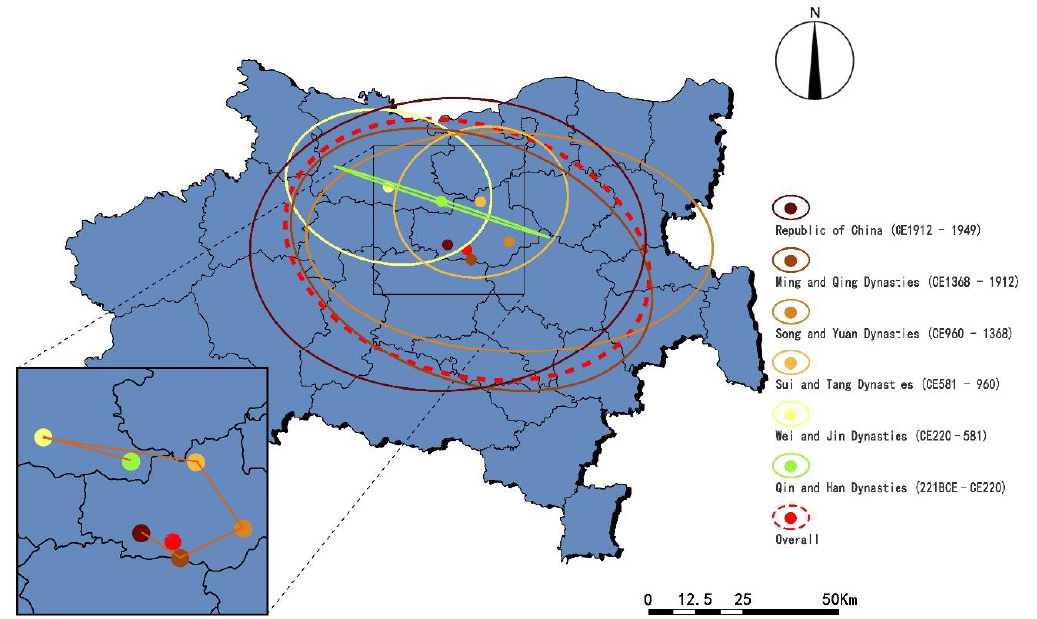
Figure 9. Standard deviation ellipse of the evolution of the distribution of historical buildings in different periods. Table 3. Standard deviation ellipse index of the evolution of the distribution of historical buildings in different periods.